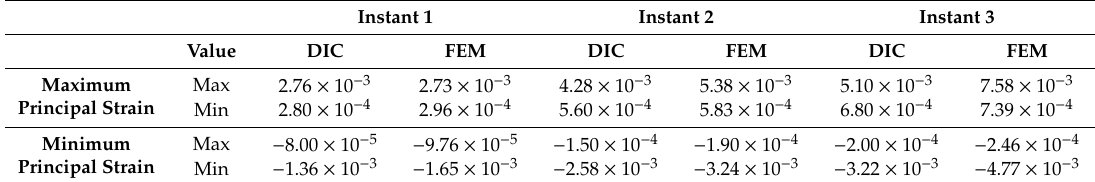
Figure 13. Comparison of displacement and strain fields between DIC estimation and numerical prediction for geometry A.